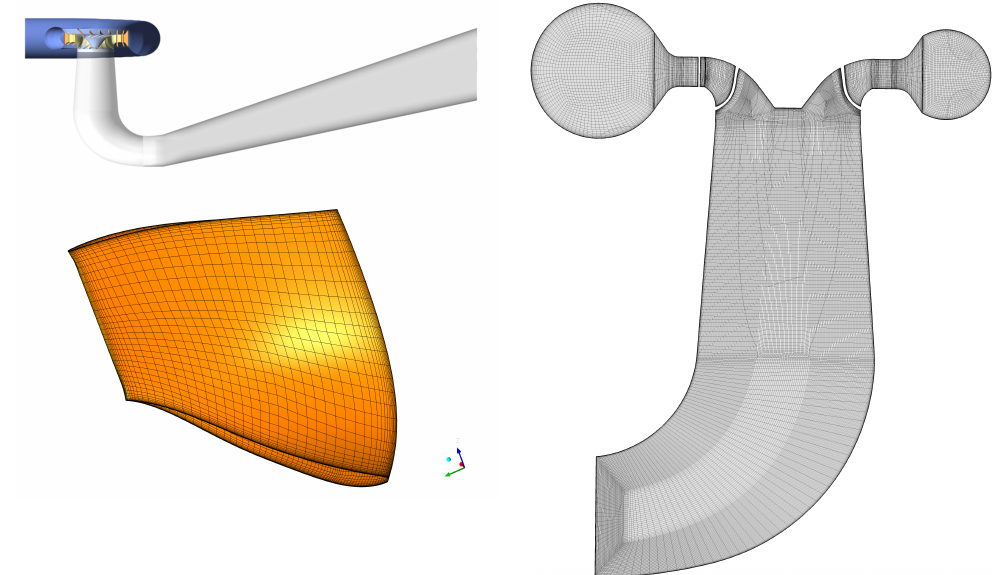
Figure 2. Computational domain (left top), view of the surface mesh of blade (left bottom) and side view of the structured mesh in a mid-plane (right). Table 1. Parameters set for the time integration. Bold terms refers to the imposed values by the user.